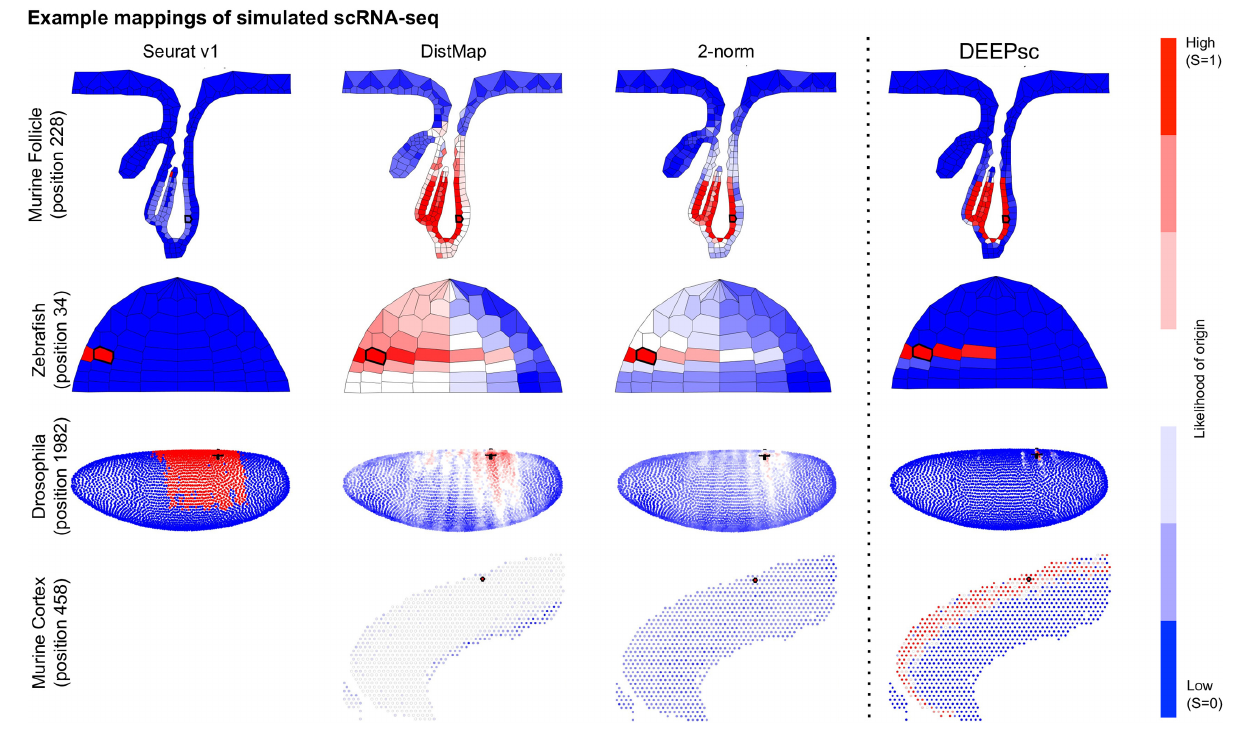
FIGURE 4 | Example mappings of simulated single cells produced by various existing methods on four different biological systems, with DEEPsc mappings for comparison. The simulated input cell for the murine follicle system corresponds to position 228. For the Zebrafish system (for which Seurat was introduced), the simulated input cell corresponds to position 34. For Drosophila (for which DistMap was introduced), the simulated input cell corresponds to position 1982. For the murine frontal cortex, the simulated input cell corresponds to position 458. Each known position is highlighted in black in each of the